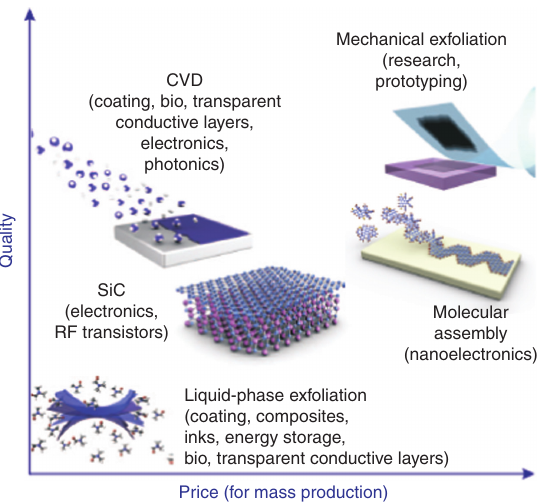
Figure 1 A roadmap for mass production of graphene. Reprinted with permission from Macmillan Publishers Ltd (copyright 2012 [1]).